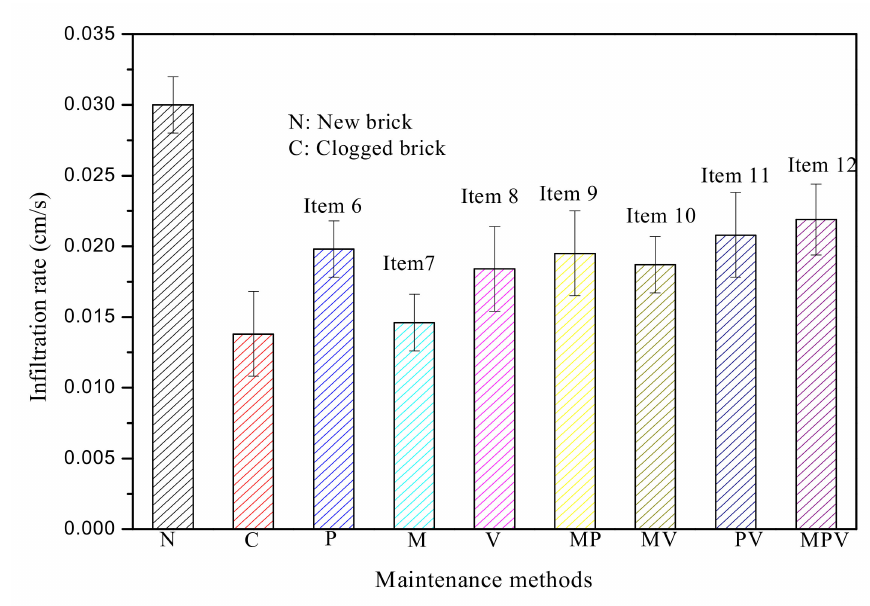
Figure 5. The recovery effects of different maintenance